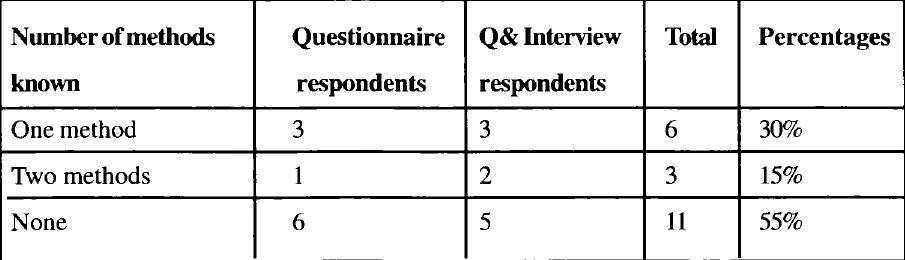
Table Four (n=20) Female knowledge of contraceptive methods for